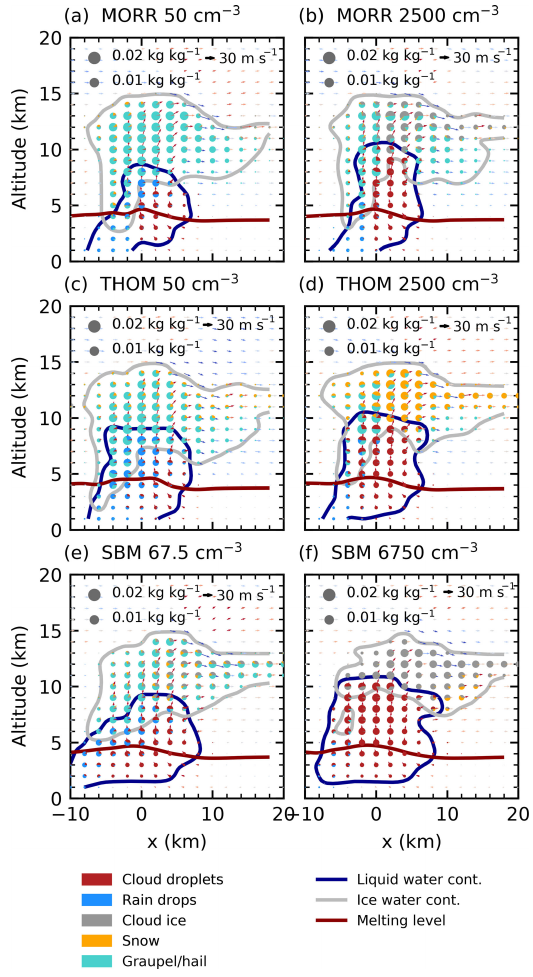
Figure 5. Hydrometeor mass mixing ratios in a slice along the line of travel of the cell for the cleanest (a, c, e) and most pol- luted (b, d, f) simulations after 60min of simulation for the three microphysics schemes in